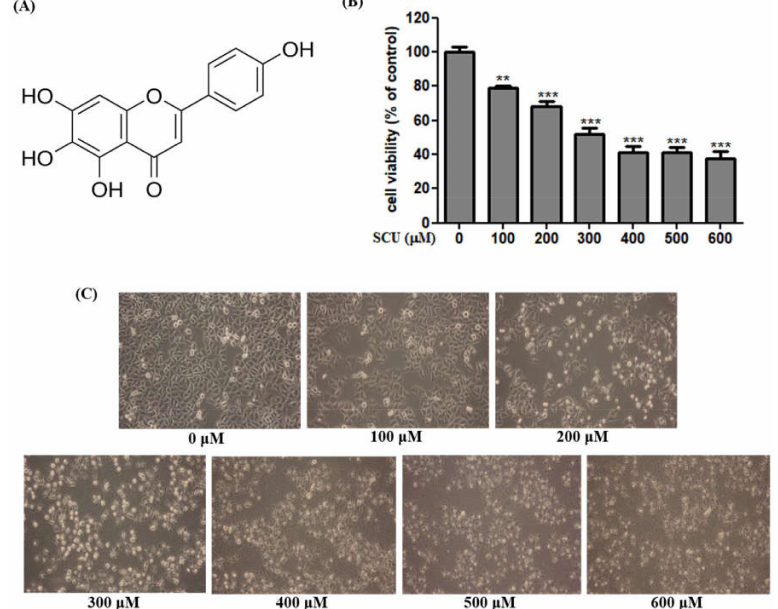
Figure 1. Scutellarein (SCU) inhibits proliferation of Hep3B cells. ( A ) Structure of SCU ( B )